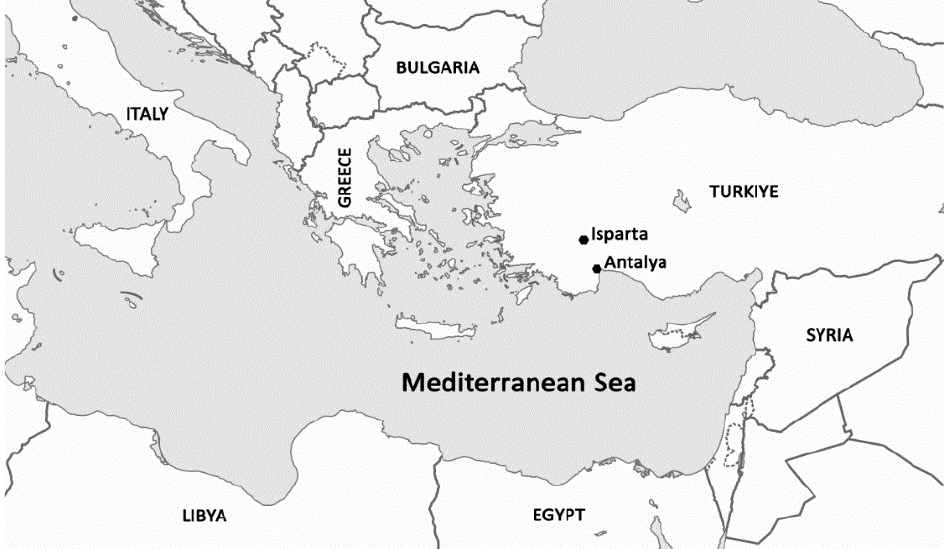
Figure 1. (•) The site of experimental areas (Isparta (37°50 ′ 12.3 ′′ N 30°32 ′ 31.1 ′′ E) and Antalya Figure 1. ( • ) The site of experimental areas (Isparta (37 ◦ 50 (cid:48) 12.3 (cid:48)(cid:48) N 30 ◦ 32 (cid:48) 31.1 (cid:48)(cid:48) E) and Antalya (36°53 ′ 56.2 ′′ N 30°38 ′ 30.3 ′′ E), Turkiye). (36 ◦ 53 (cid:48) 56.2 (cid:48)(cid:48) N 30 ◦ 38 (cid:48) 30.3 (cid:48)(cid:48) E), Turkiye).